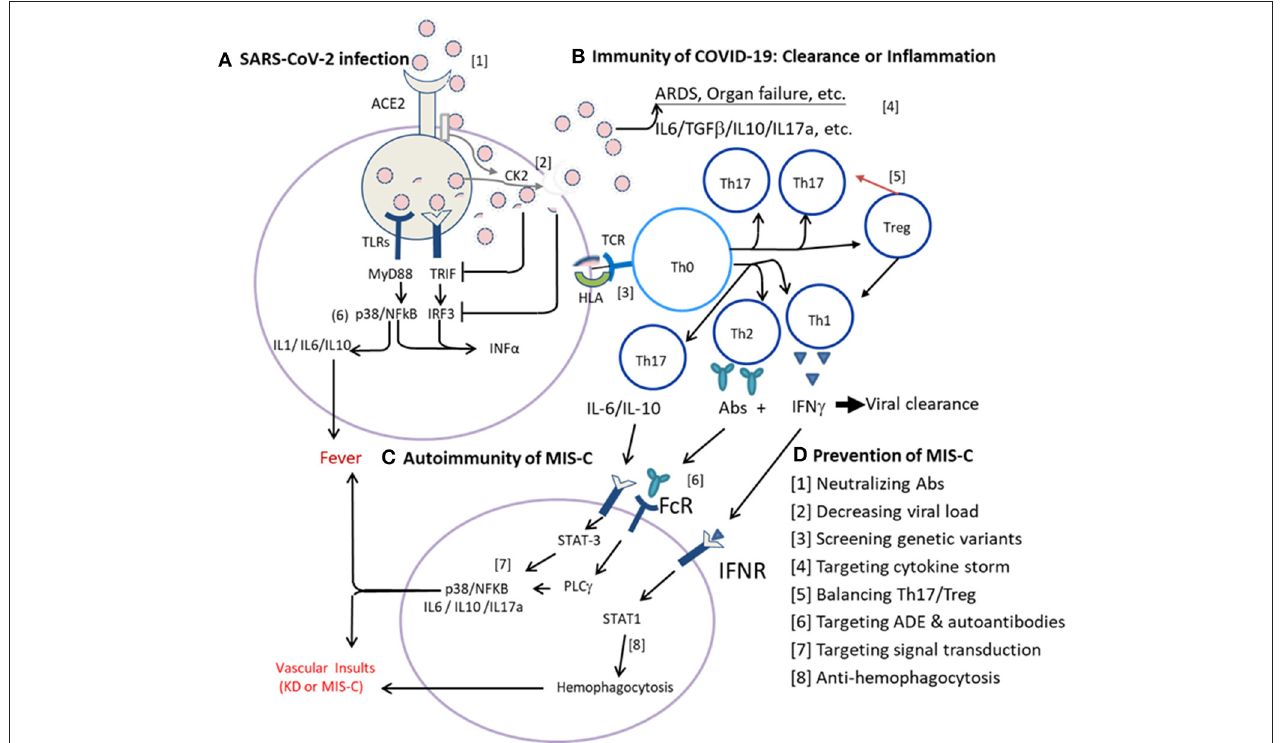
FIGURE 1 | Immunotherapies of multisystem inflammatory syndrome in children (MIS-C) based on infection immunity and autoimmunity. (A) Innate immunity of severe acute respiratory syndrome coronavirus-2 (SARS-CoV-2) infection to cells via ACE2. The SARS-CoV-2 virus enters host cells via ACE2 where a serine protease cleaves the viral spike (S) protein and allows the virus to fuse with the plasma membrane for internalization. Host RNA sensing receptors, such as RIG-1 (DDX58), Toll-like receptor-3 (TLR3), TLR7, and/or TLR8, detect the internalized virus and induce the production of interferons (IFNs) via MyD88, TRIF (TICAM1), IRF3, and/or IRF7 pathways, promote production of proinflammatory cytokines via MAPK (e.g., p38) and NFkB pathways. Normally, the host RNA sensing receptor(s) of RIG-1 and TLR7 signaling pathways will mediate an effective induction of IFNs for virus clearance. While the virus hijacks RNA sensing receptors and pathways or activates casein kinase 2 (CK2) for filopodial protrusion of budding viral particles, the virus multiplies rapidly and the infection spreads systemically. (B) Adaptive immunity of coronavirus disease-19 (COVID-19). Upon antigen presentation for T-cell adaptive immunity via human leukocyte antigen (HLA), an optimal adaptive immunity with T-cell immunity and B-cell production of neutralizing antibodies (Abs) for virus clearance is normally elicited. While the initial virus load is high, or the TLR is either of congenital deficit or of acquired deficit as in the elderly, or the viral glycoproteins (antigens) could suppress the MyD88, TRIF, IRF3, and/or IRF7 signaling pathways, the antigen-presenting cells (APCs) are hijacked and present the viral antigen with an altered signal for the polarization of naïve T helper cells (Tho) toward Th17 response with inflammatory cytokines production, but not Treg regulation for a proper Th1 cell immunity and/or Th2 humoral (B cell) response for neutralizing antibody production. (C) Individual autoimmunity with MIS-C. In convalescence, most patients recovered due to efficient adaptive immunity of Th1 cell immunity and Th2 neutralizing Abs unless individual subjects with genetic susceptibility or altered endogenous milieu. For instance, the viral antigens (PAMPs) interact with individual HLA subtype(s) of APCs and induce altered autoimmunity with Th17/Treg imbalance and augmented cytokine storm of IL-6, IL-17A, and/or IL-10 expression or abnormal autoantibodies resulting in MIS-C with systemic vasculitis, thrombosis, and shock, as seen in MIS-C. In addition, certain host milieu, e.g., abnormal homeostasis of vitamins and microbiota which could compromise Treg responses and enhance Th17/Treg imbalance. Alternatively, altered Fc γ R or subneutralized IgG antibodies might induce antibody-dependent enhancement (ADE) of immune reaction, and autoantibodies to form immune complex or to bind endothelial cells and